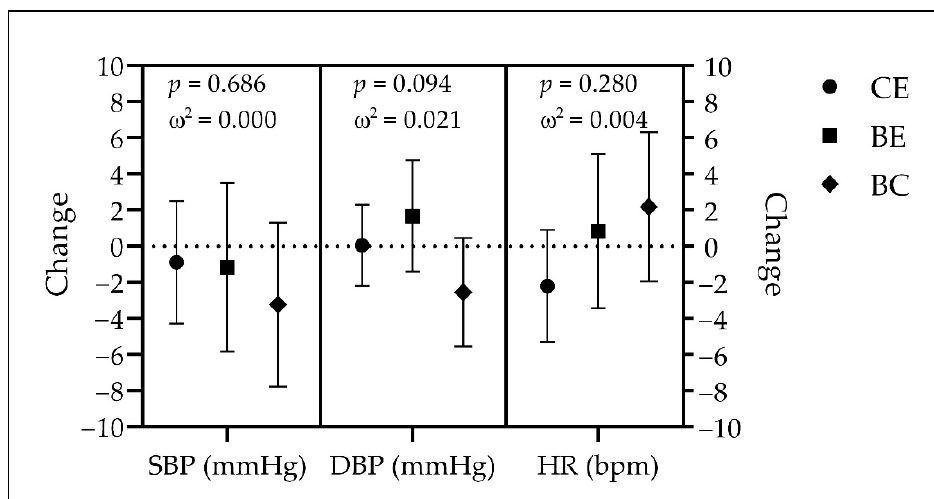
Figure 3. Changes over time in SBP, DBP, and HR. Data expressed as least squares mean and 95% confidence intervals; p -values calculated with one-way ANCOVA for group comparisons (adjusted for age, sex, marital status, income, and employment); omega squared ( ω 2 ) as effect size. BC: Brazilian control group (diamonds); BE: Brazilian experimental group (squares); CE: Canadian experimental group (circles); DBP: diastolic blood pressure; HR: heart rate; SBP: systolic blood pressure.